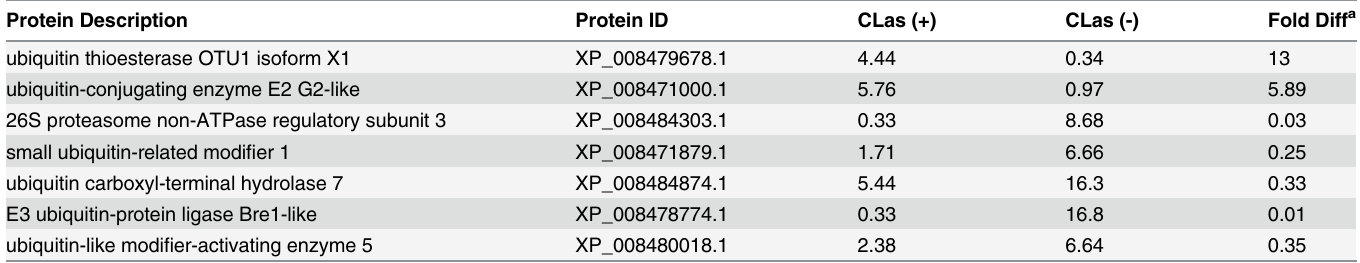
Table 4. D . citri ubiquitin related proteins differentially expressed between CLas(+) and CLas(-) insects. Average normalized peptide count from specified proteins and fold difference: CLas(+)/CLas(-). Protein Description